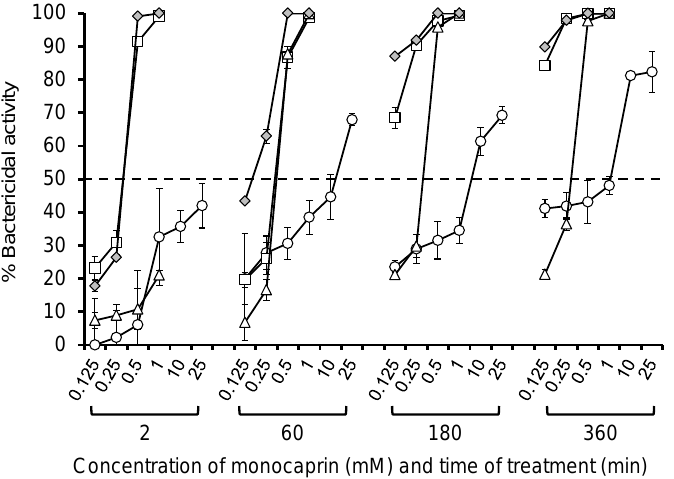
Concentration of monocaprin (mM) and time of treatment (min) Staphylococcus aureus Pseudomonas aeruginosa Figure 1. Bactericidal activity of monocaprin against a variety of different bacteria. Bacteria (~10 3 colony-forming units (CFU) in triplicate wells) were treated with various doses of monocaprin (0.125–25 mM), and variability was determined using viable counting on selective agar at various time points (2–360 min). The symbols represent the mean bactericidal activity, calculated as the percentage of (surviving bacteria/the number of untreated control bacteria) × 100 from n = 2–3 independent experiments. The error bars are the standard errors of the